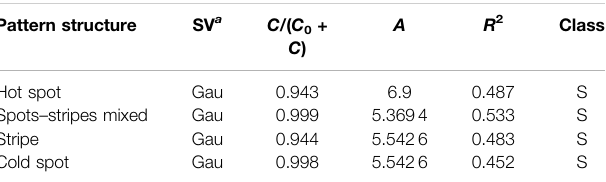
TABLE 4 | Fitted semivariogram models (SV) and its characteristic parameters for different infected pattern ( Figure 5 ). The meanings of other parameters are consistent with Table 2 .